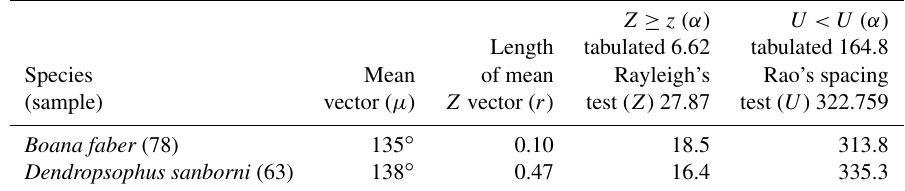
Table 5. Species with unidirectional behavior in quadrant III of the polar axis (135–225 ◦ ) clockwise, under the influence of the synodic cycle between waxing gibbous and waning gibbous (higher albedo); n − 1 degrees of freedom and p = 0 .